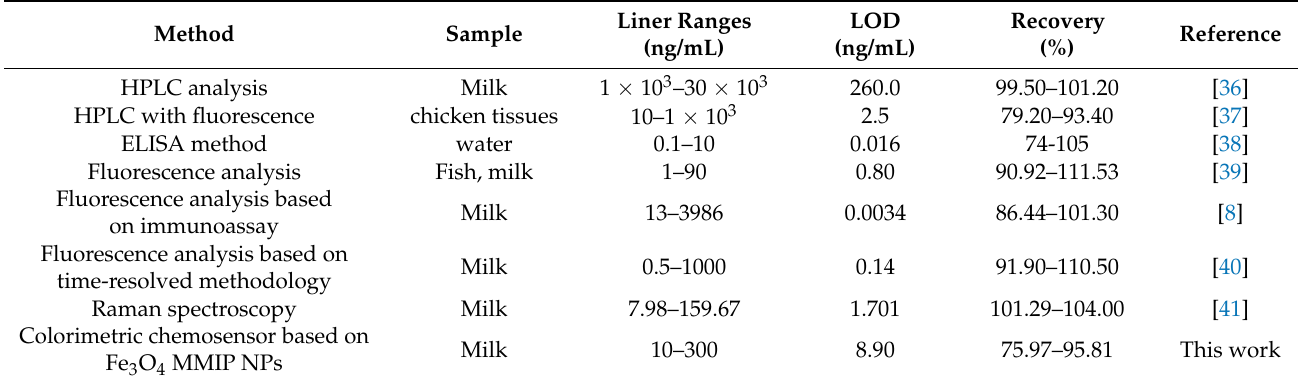
Table 3. Comparison of detection methods for